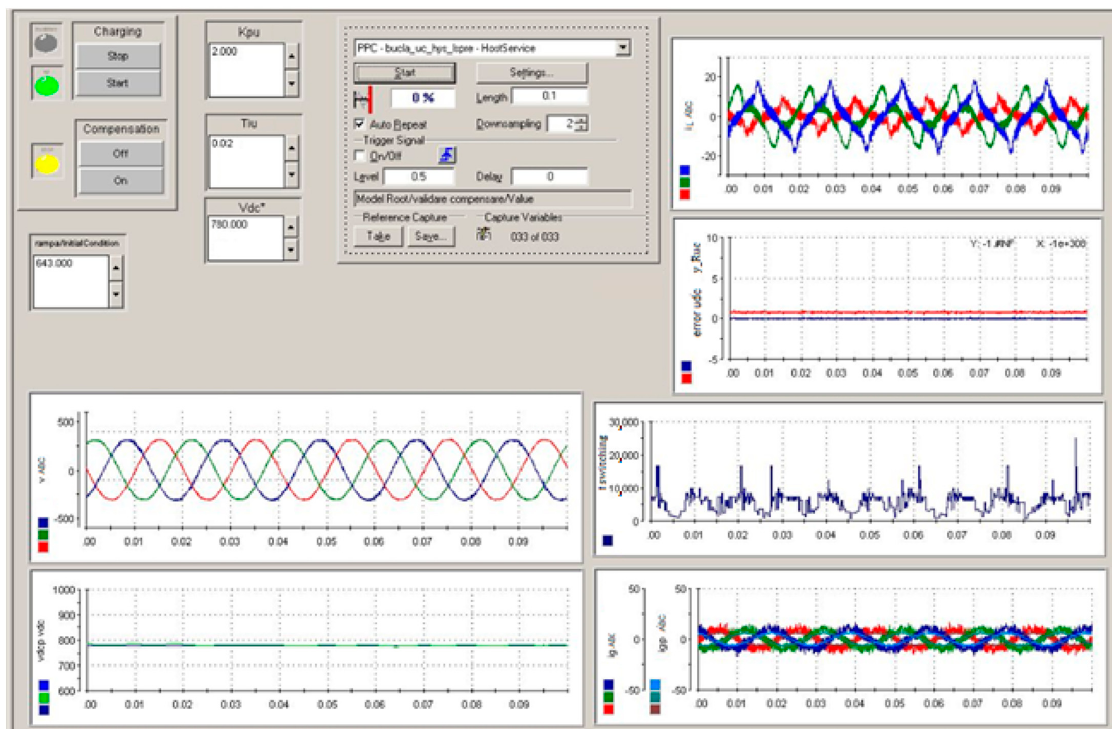
Figure 12. The conceived graphic interface.